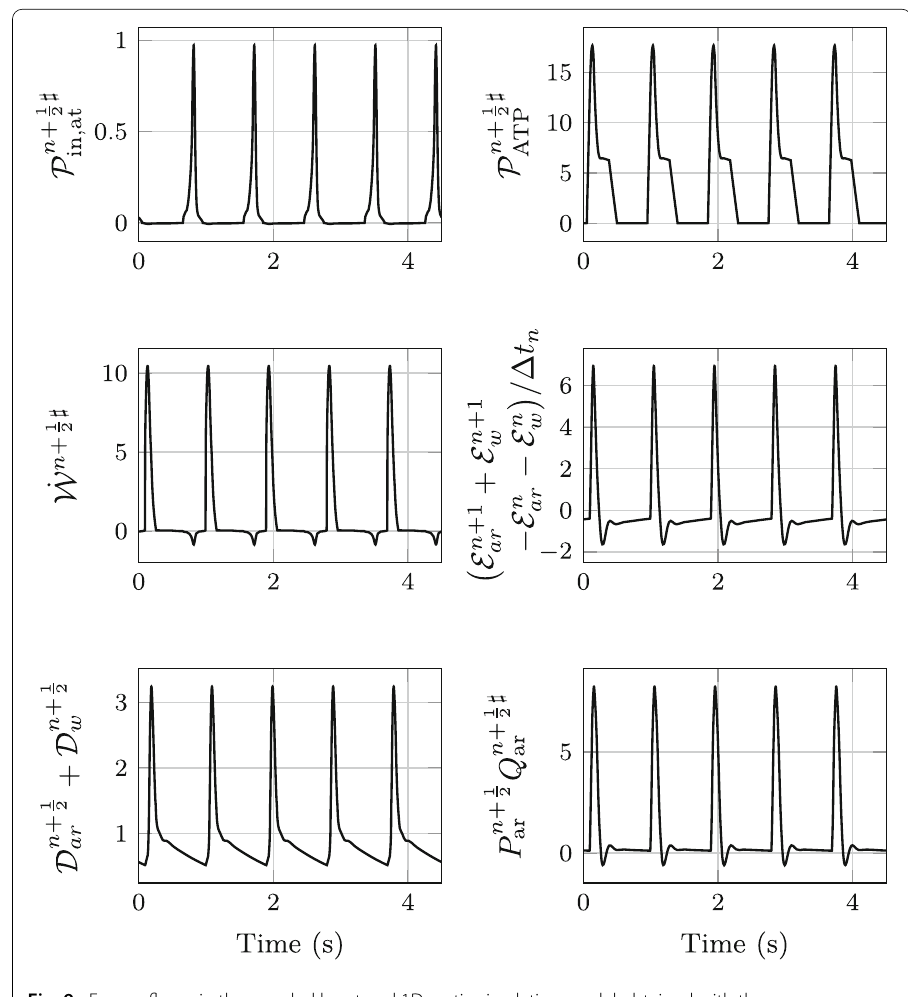
Fig. 9 Energy fluxes in the coupled heart and 1D aortic circulation model obtained with the energy-preserving numerical scheme. All quantities are given in Watts